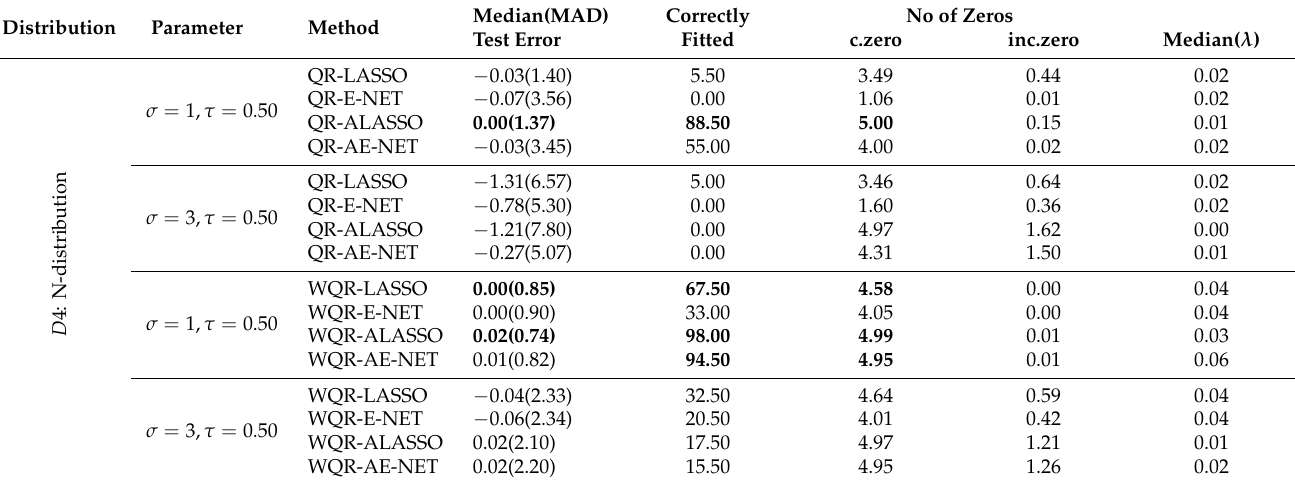
Table A1. Penalized weighted and unweighted quantile regression at D 4 for n = 50 ( τ = 0.50) under the normal distribution.